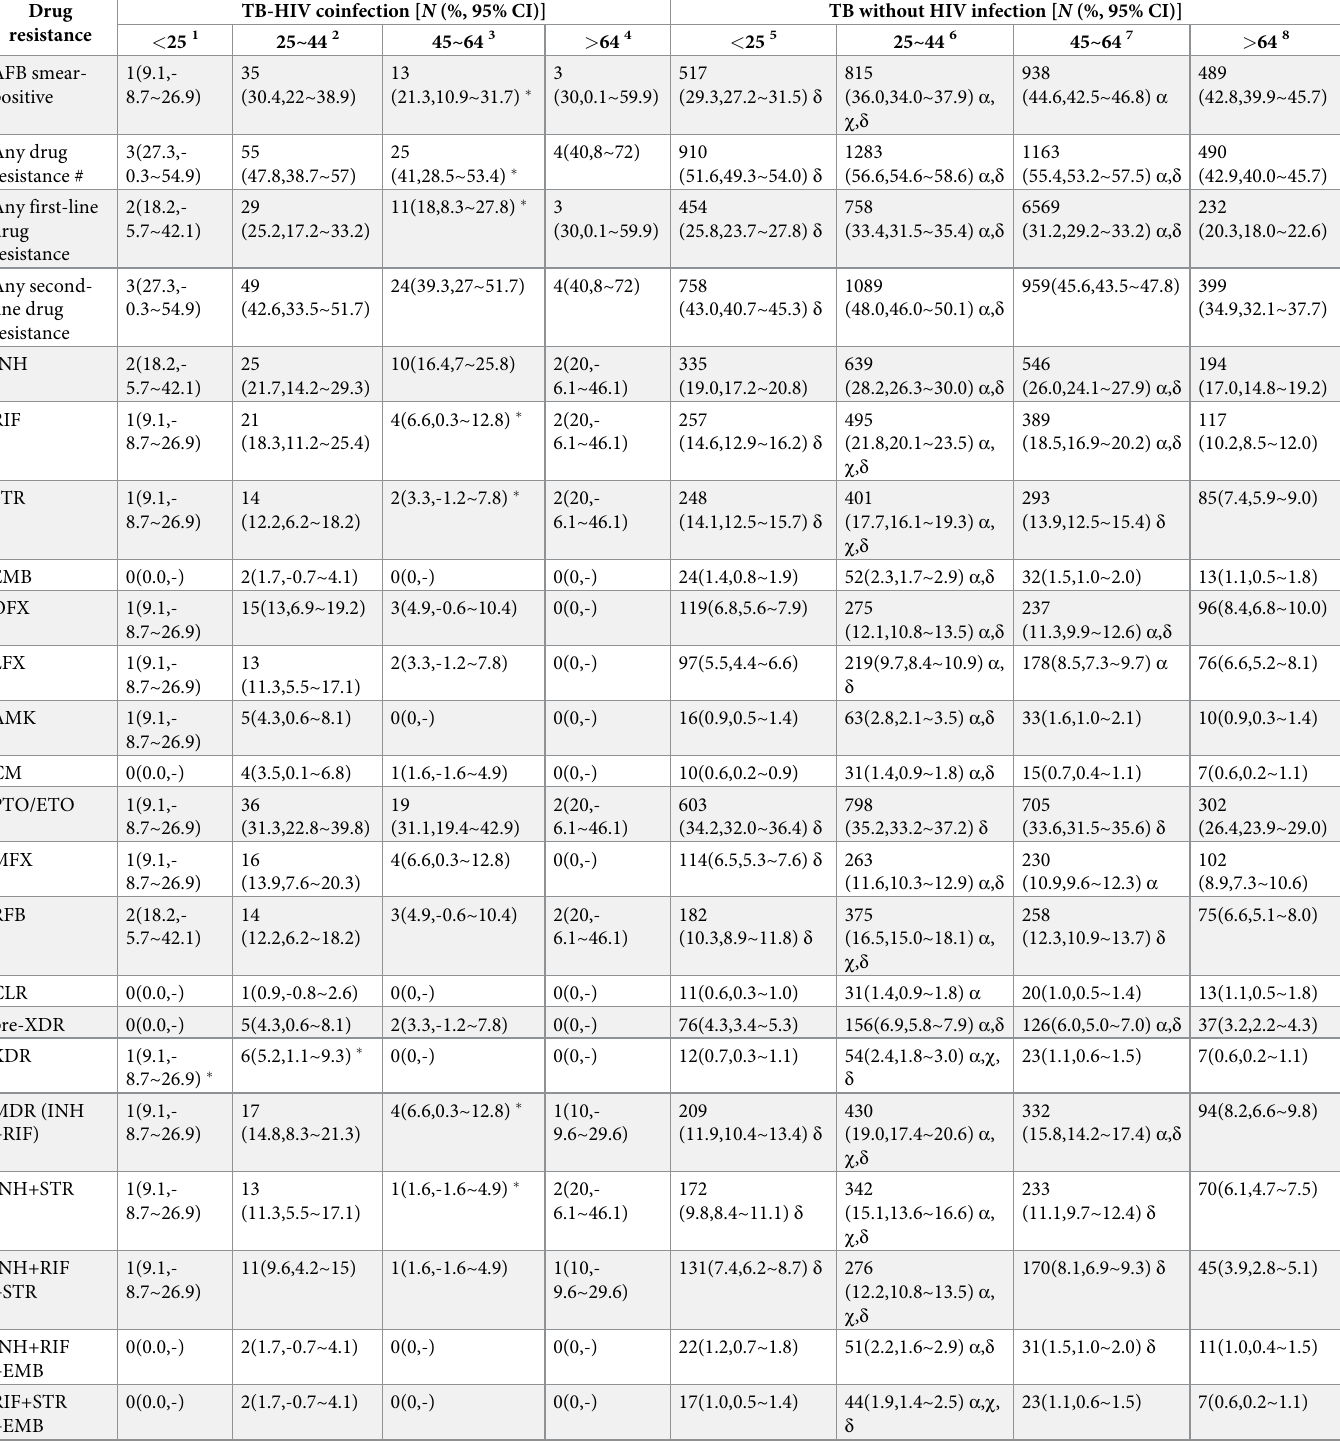
Table 2. Drug-resistant distribution of Mycobacterium tuberculosis isolates in different age groups. Drug